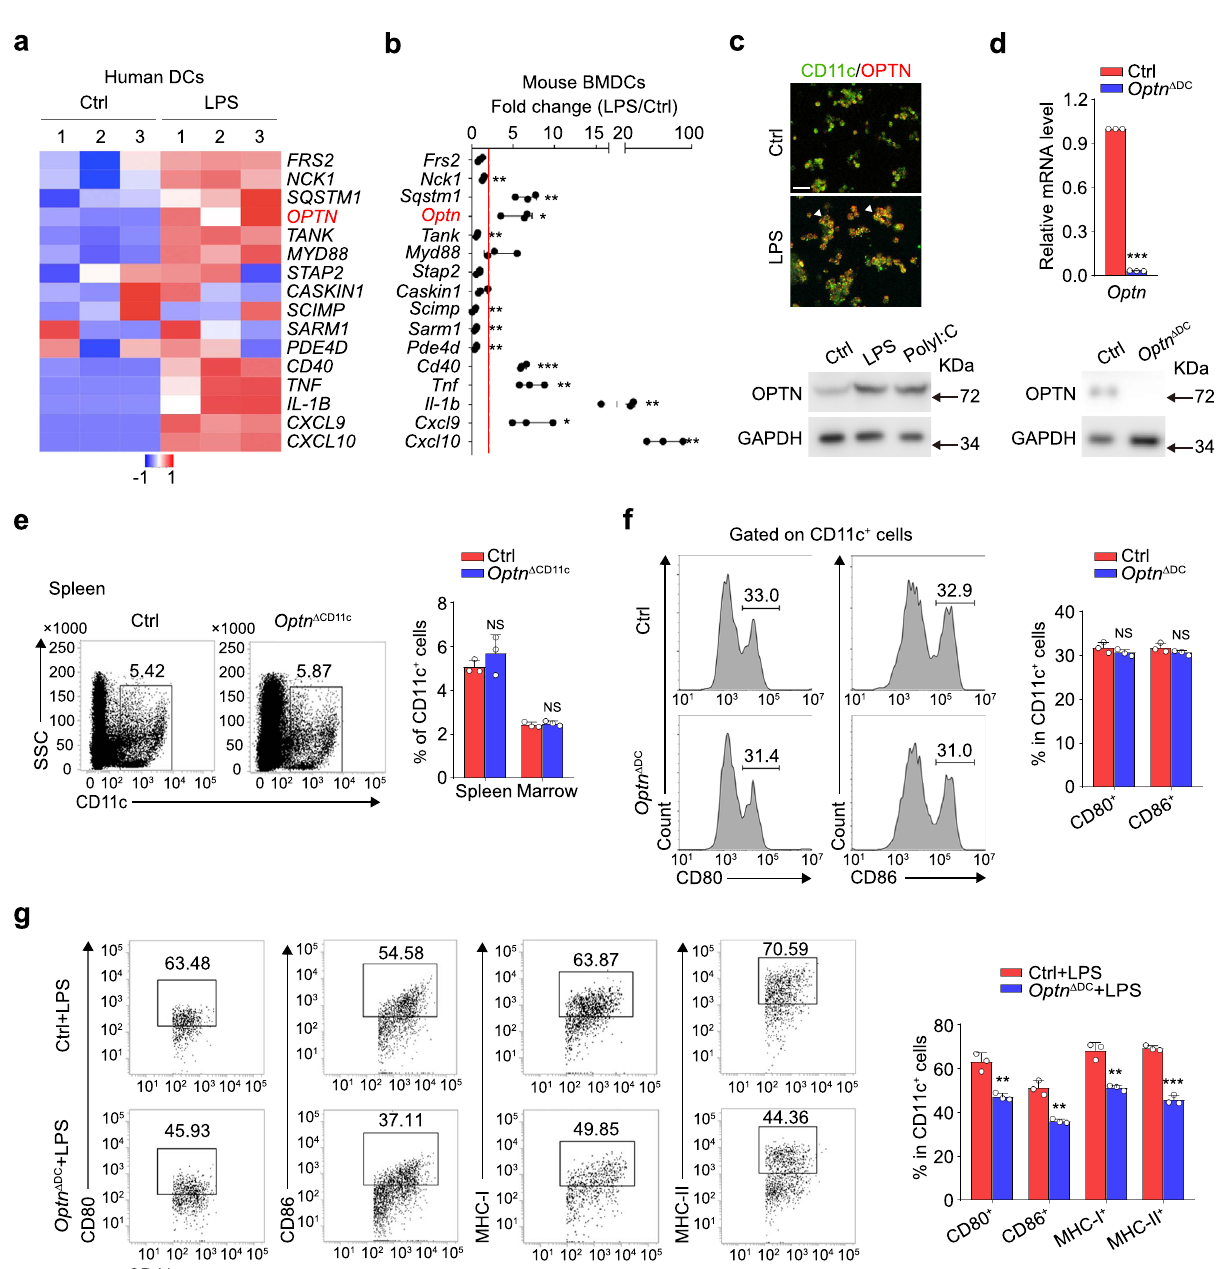
Fig. 1 OPTN expression is required for DC maturation. a Heatmap of the indicated gene expression levels in human MoDCs stimulated with LPS for 8 h or unstimulated from GEO dataset (GSE2706). b qRT-PCR analysis of selected gene expressions in BMDCs stimulated with LPS for 8 h. Red line, relative